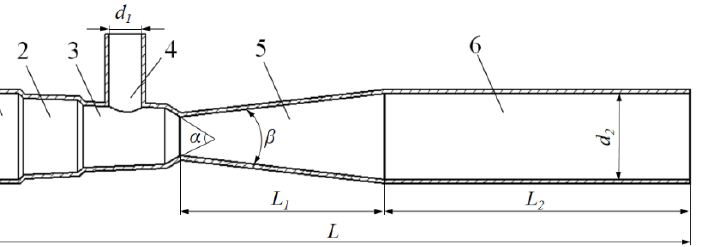
Figure 4. Venturi ejector: 1. Air inlet. 2. Shrinking tube. 3. Throat tube. 4. Feeding tube. 5. Diffusion tube. 6. Mixing tube.